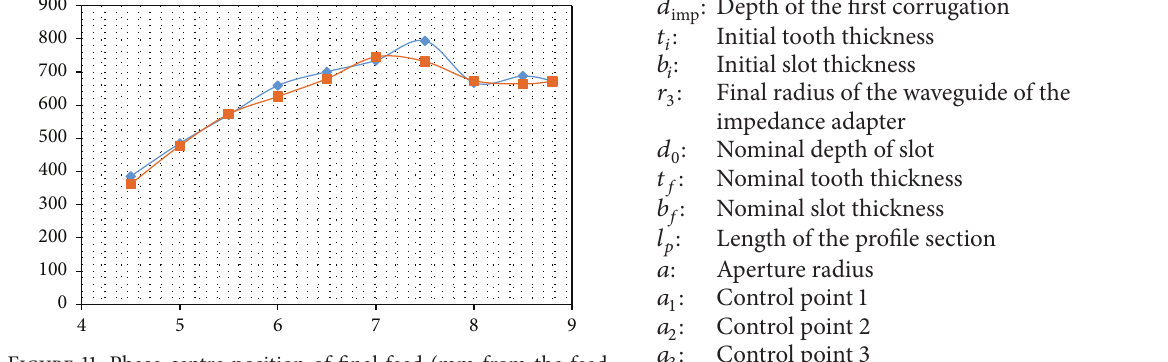
Figure 11: Phase centre position of final feed (mm from the feed aperture). Measured (blue); simulation (orange).